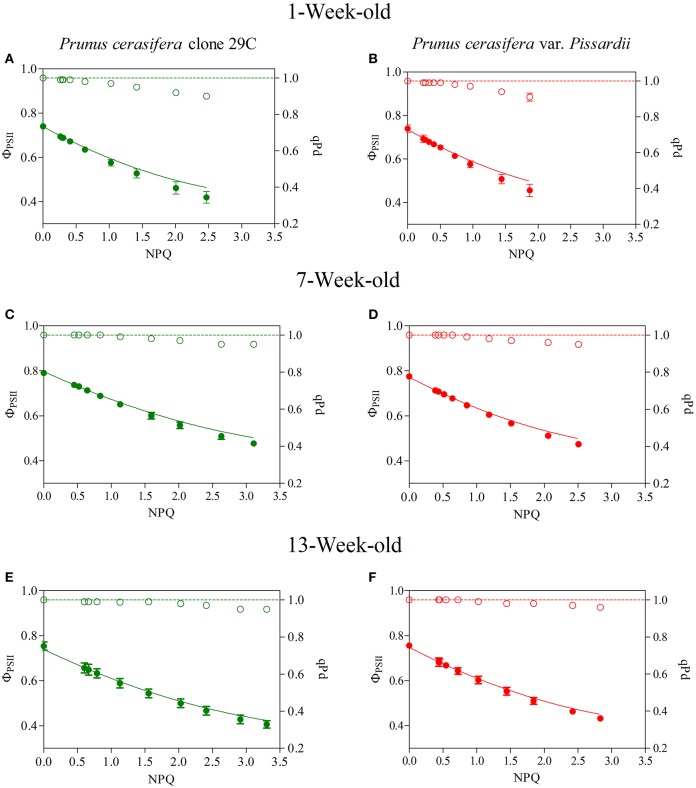
Relationship between NPQ and qPd (open circles) and NPQ and photosystem II effective quantum yield (closed circles) determined in 1-, 7-, and 13-week-old leaves of Prunus cerasifera clone 29C (A,C,E, respectively) and Prunus cerasifera var. Pissardii (B,D,F, respectively). Data are means of at least 12 replicates of intact leaves; error bars represent the standard error. Theoretical quantum yield (continuous line) was calculated using the Equation (1) reported I Materials and Methods section with qPd = 1.